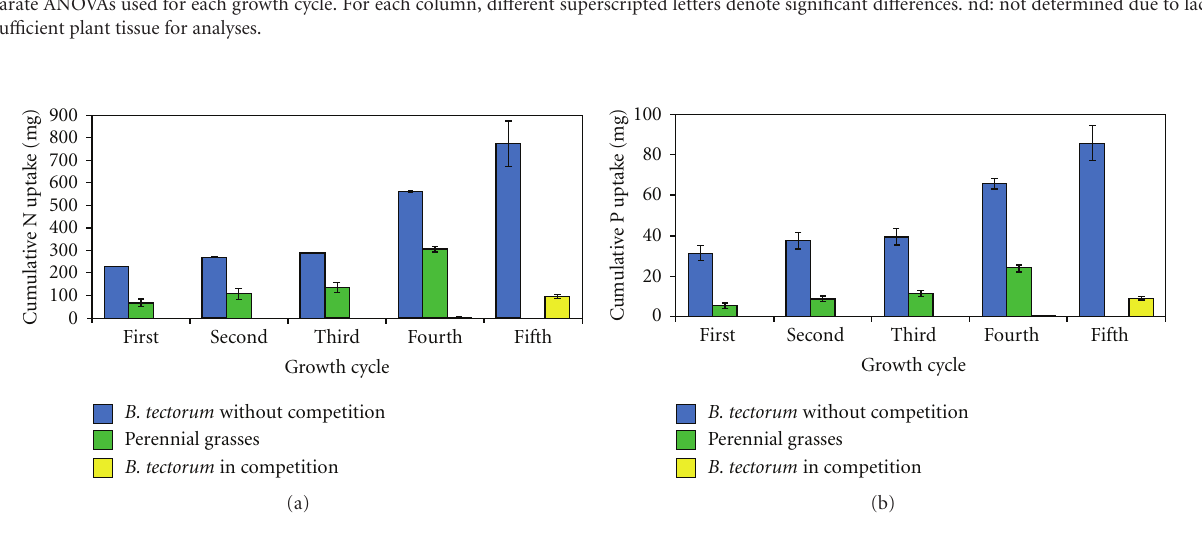
Figure 2: Graphs showing cumulative plant uptake of nitrogen and phosphorus by growth